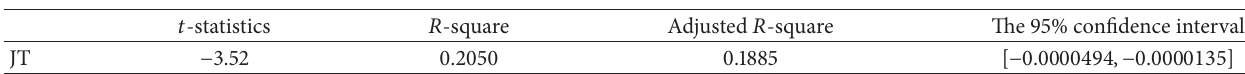
Table 7: Statistical parameters of JT on